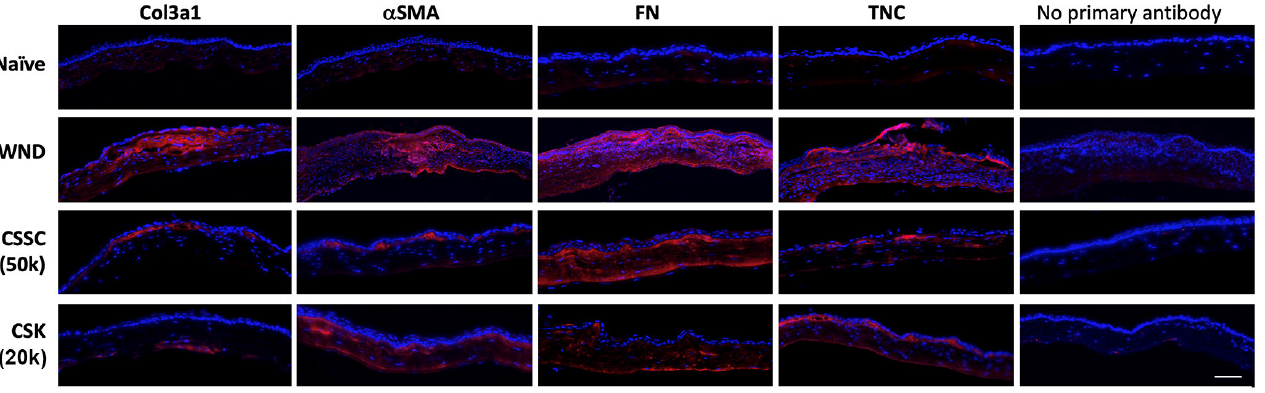
Figure 6. Immunostaining of fibrosis markers in mouse corneal sections after cell treatments. The expression of Col3a1, α SMA, fibronectin (FN), and tenascin C (TNC) was examined in mouse corneas (naïve and wound controls), compared to corneas treated with 50 × 10 3 CSSC or 20 × 10 3 q-CSK for 2 weeks; scale bar: 50 μ m.